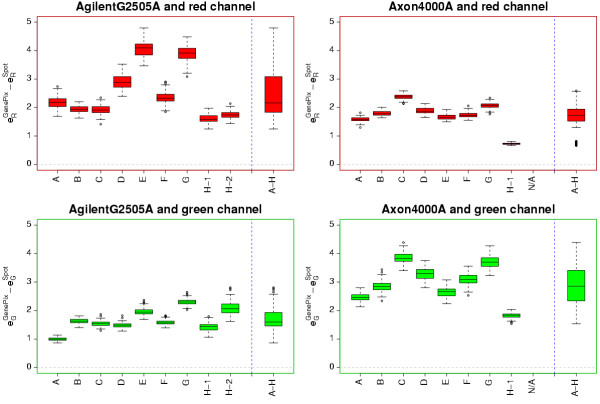
Comparison of bias estimates between image analysis methods. Differences in the common biases ec between the GenePix and the Spot image analysis method for each separate array and for all arrays together. The bias is significantly larger for GenePix, regardless of channel (top and bottom) and scanner (left and right).